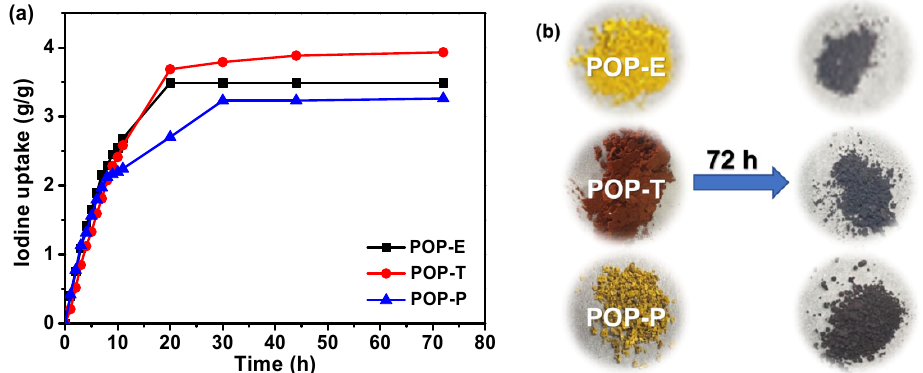
Figure 3. ( a ) Iodine vapor adsorption curves at 75 °C under ambient pressure for POP-E, POP-T and POP-P, ( b ) Colour change of POP samples before and after iodine vapor adsorption. Compared with reported POPs, it is obvious that POP-E, POP-T and POP-P exhib- ited outstanding iodine adsorption capacity, better than most other materials (Table